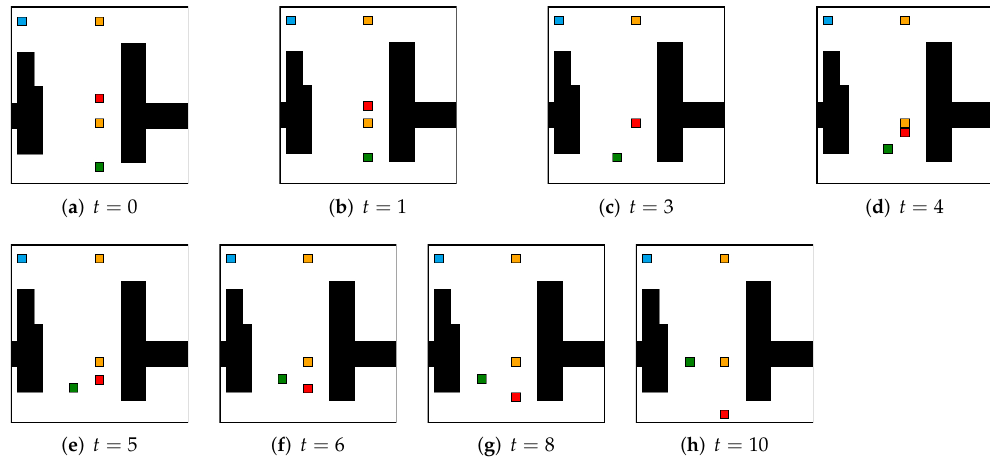
Figure 10. The trajectory of the agent under the condition of k 1 = 0, k 2 = 1 set in f .